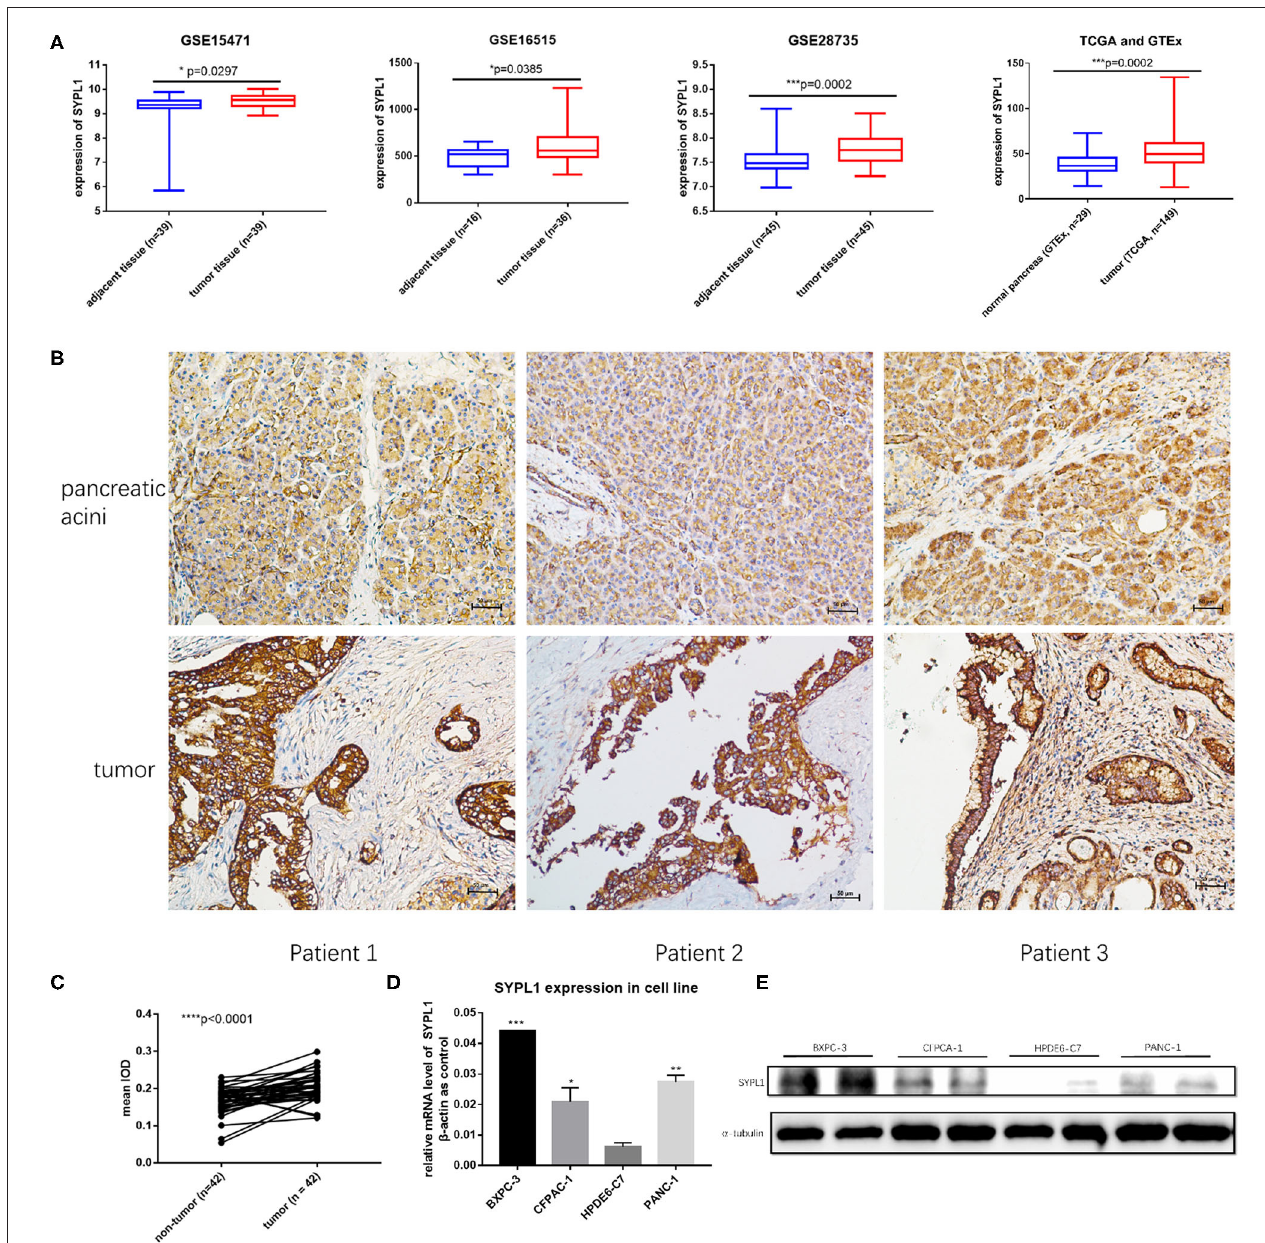
FIGURE 1 | SYPL1 was upregulated in pancreatic ductal adenocarcinoma (PDAC). (A) SYPL1 was upregulated in PDAC at the transcription level (GSE15471, GSE16515, GSE28735, TCGA, and GTEx datasets were used). (B) The expression of SYPL1 in tumor and pancreatic acini at the protein level. Tissue sections from three PDAC patients were used as examples. (C) Quantification of SYPL1 protein levels in 42 paired tumor sections and pancreatic acini sections. (D) Quantification of SYPL1 RNA in PDAC cell lines (BXPC-3, CFPAC-1, and PANC-1) and immortal human pancreatic duct epithelial cell lines HPDE6-C7. (E) SYPL1 protein levels in cell lines. * p < 0.05, *** p < 0.001 and **** p < 0.0001.